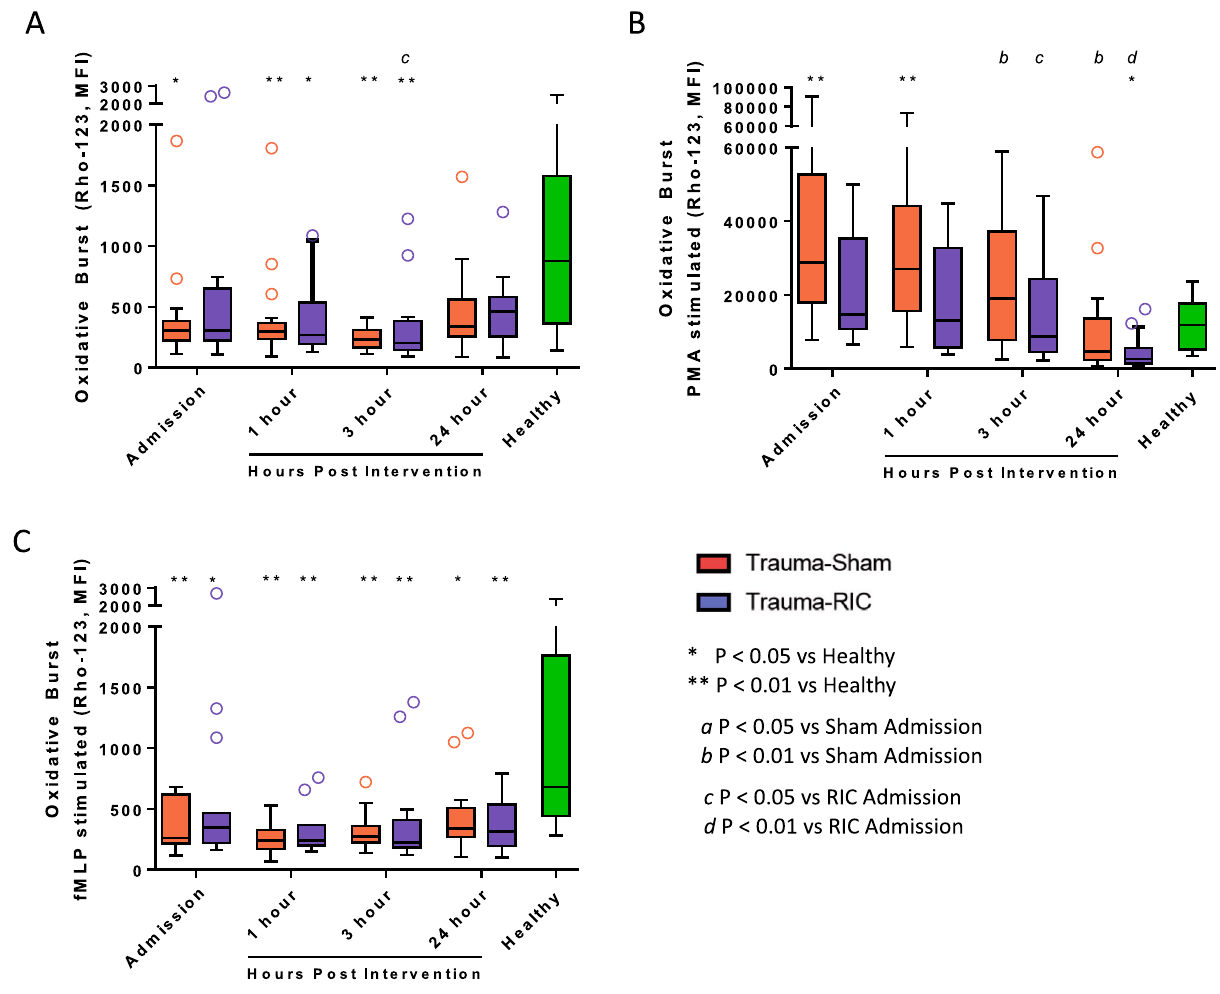
Figure 2. Neutrophil oxidative burst capacity from trauma patients expressed in median fluorescence intensity (MFI). (A) Unstimulated cells. (B) PMA stimulated cells. (C) fMLP stimulated cells. Lines represent the median and interquartile range. Red open circle = Trauma-Sham. Blue open circle = Trauma-RIC. Green open circle = Healthy Controls. a P < 0.05 vs Sham Admission. b P < 0.01 vs Sham Admission. c P < 0.05 vs RIC Admission. d P < 0.01 vs RIC Admission. *P < 0.05 vs Healthy Controls. **P < 0.01 vs Healthy